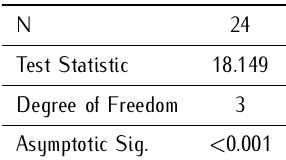
Table 1. Results of Friedman test on Connection